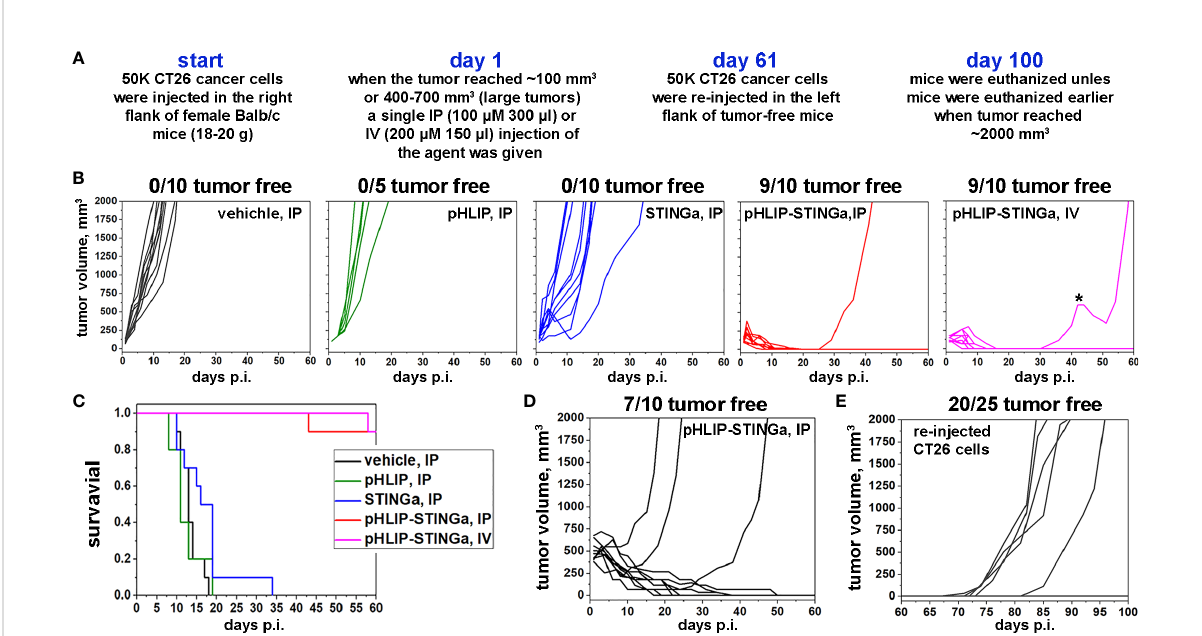
FIGURE 3 Eradication of CT26 tumors and development of immune memory. (A) Experimental design. (B) CT26 tumor growth curves in Balb/c mice are shown after a single administration of different agents at dose levels of 100 m M 300 m l for IP injections or 200 m M 150 m l for IV injections performed on day 1, when tumors had reached about 100 mm 3 in volume. The star (*) indicates that this mouse in IV group received a second dose of pHLIP-STINGa on day 41, when the tumor had started to re-grow. (C) Kaplan-Meier survival plots obtained for the data shown in panel (B) . (D) CT26 large tumor growth curves are shown after a single IP injection of pHLIP-STINGa (100 m M 300 m l) on day 1, when tumors had reached 400-700 mm 3 in volume. (E) CT26 tumor growth curves obtained for tumor-free mice from the groups that received single IP or IV injections, small and large tumors, of pHLIP-STINGa on day 1. On day 61 CT26 cancer cells were re-injected in the left fl anks of these mice and tumor growth was monitored for additional 40